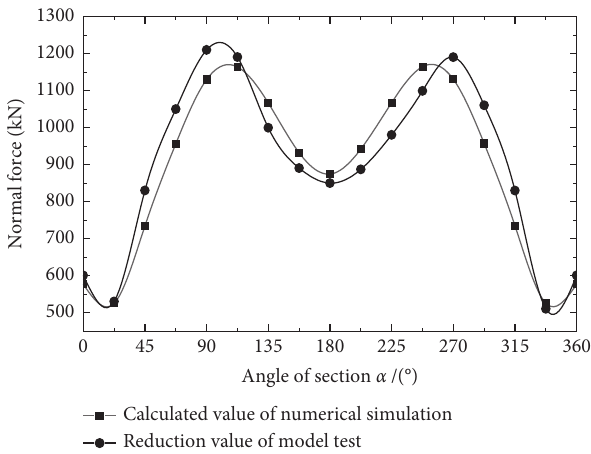
Figure 9: Comparison of axial force values of the cavity behind the vault (unit: